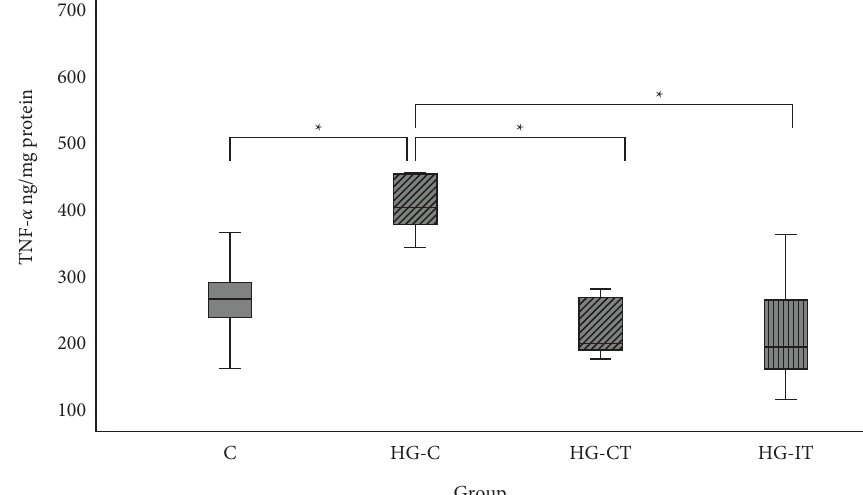
Figure 4: TNF α concentration within each group: c: control group; HG-C: hyperglycemic control group; HG-CT: hyperglycemic rats that performed moderate-intensity continuous training (MICT); HG-IT: hyperglycemic rats that performed high-intensity interval training (HIIT). Te error bars represent the standard deviation of measurements. ∗ p < 0 . 05.